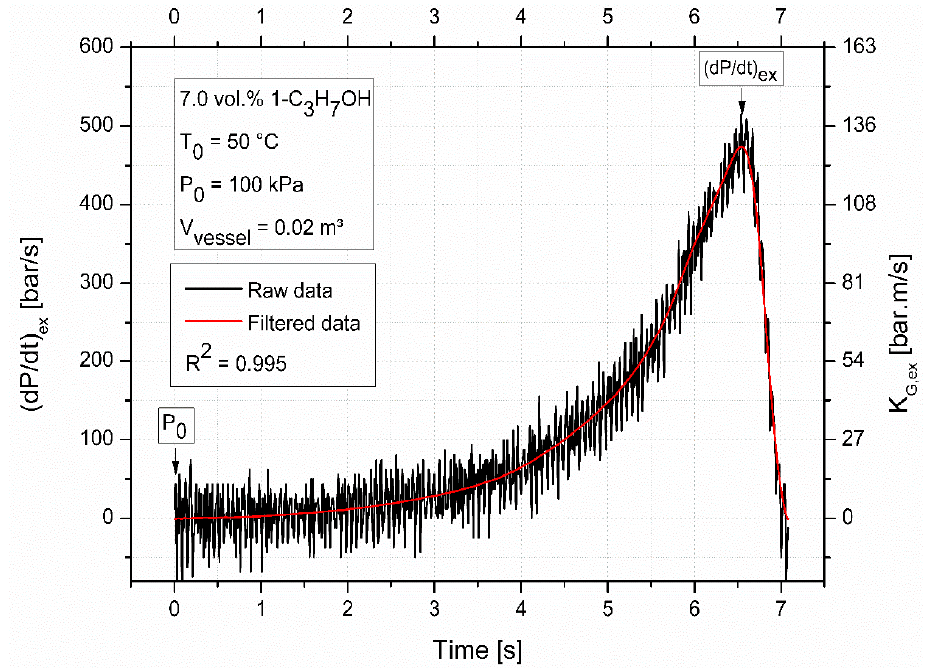
Figure 3. An illustration of the smoothing filter on the pressure–time curve determination of the explosion pressure rise.